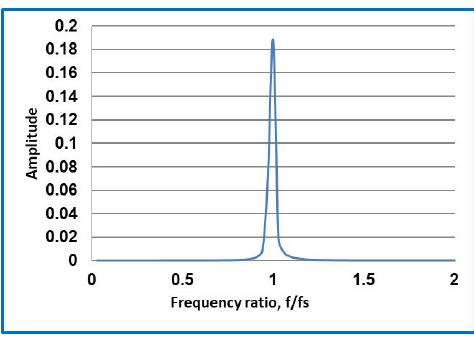
Figure 11: Power spectrum of lift coeflcient history at f v = f s , crossflow vibration